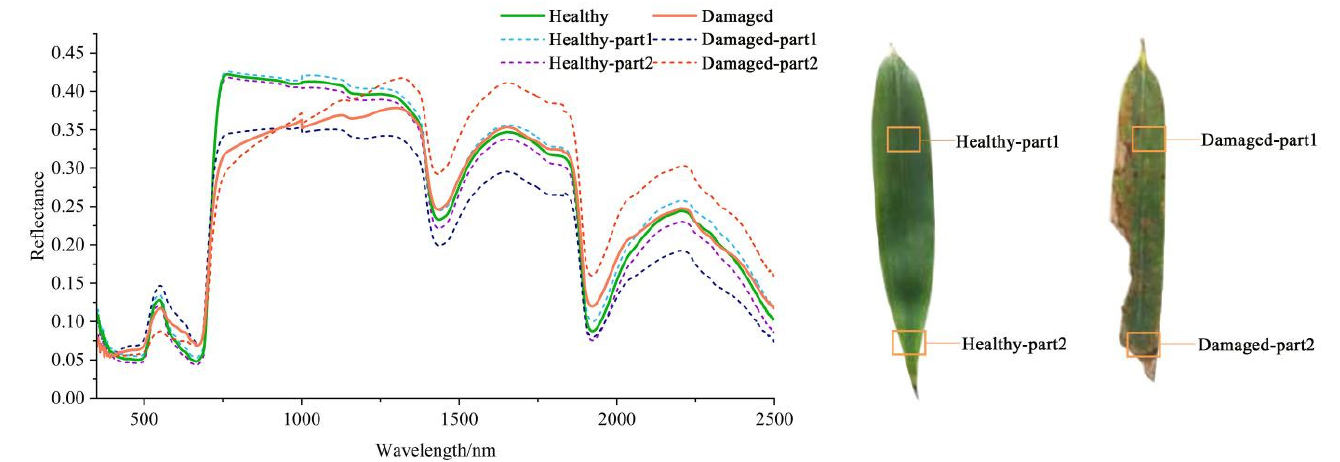
Figure 9. Spectral curve difference caused by spatial heterogeneity of the leaves. The solid green line is the average of the spectral curves of Health-part1 and Health-part2. The solid orange line is the average of the spectral curves of Damaged-part1 and Damaged-part2 .